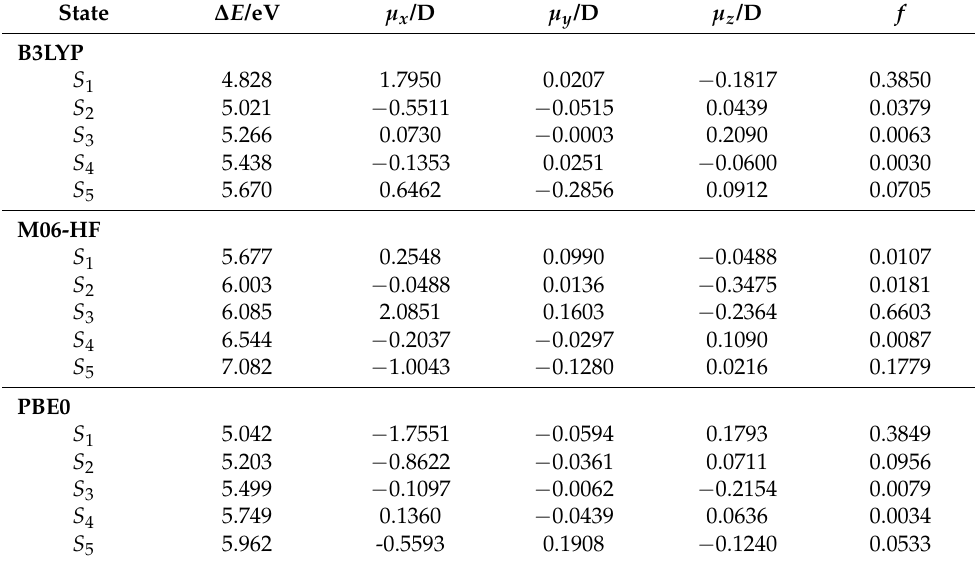
Table 2. Vertical excitation energies, transition dipole and oscillator strength for the leading terms of the singlet electronic